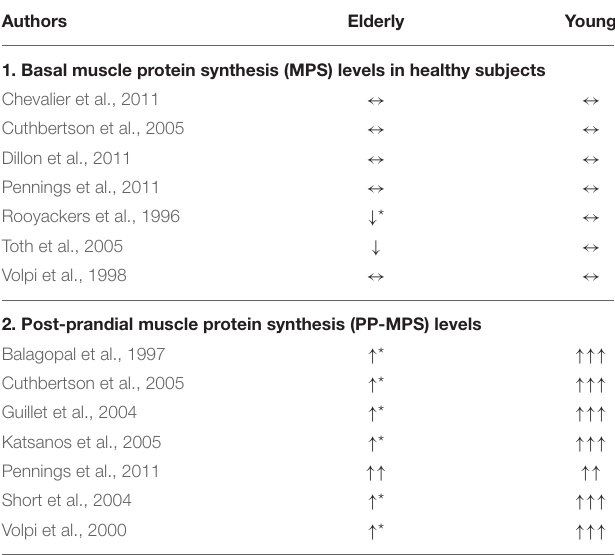
TABLE 1 | Muscle protein synthesis in elderly and young